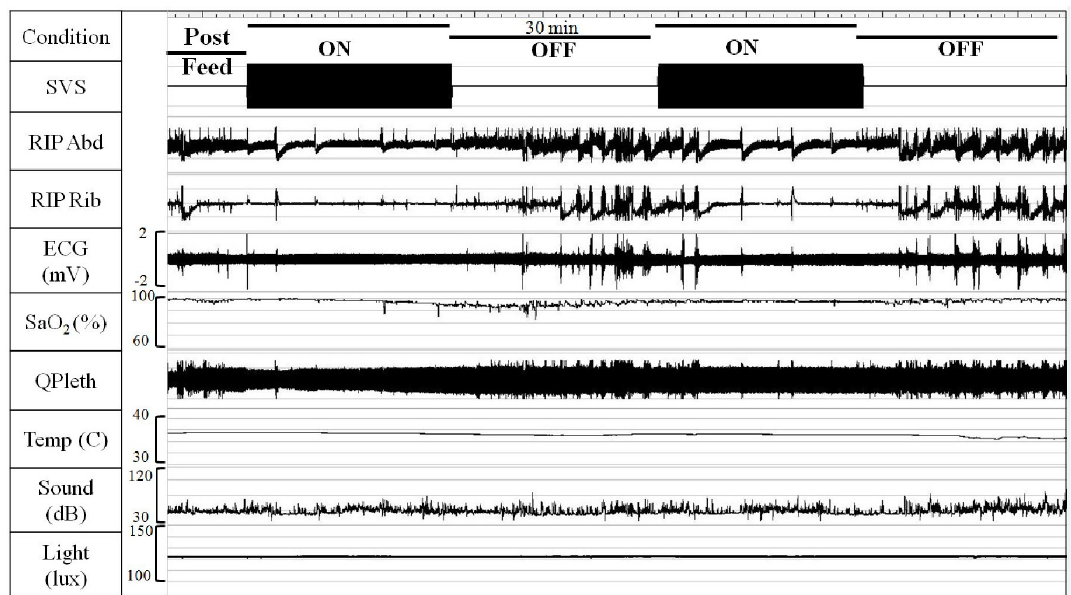
Fig 1. Example of experimental protocol and recorded signals (Subject 24). Signals are condensed. SVS = Stochastic VibrotactileStimulation; RIP = Respiratory Inductance Plethysmography; Abd = Abdomen; ECG = Electrocardiogram; SaO 2 = Blood-oxygen saturation; QPleth = Quality of Plethysmography; Temp = Temperature. Note the increase in movement artifact in the physiological signalsduringOFF comparedto ON.